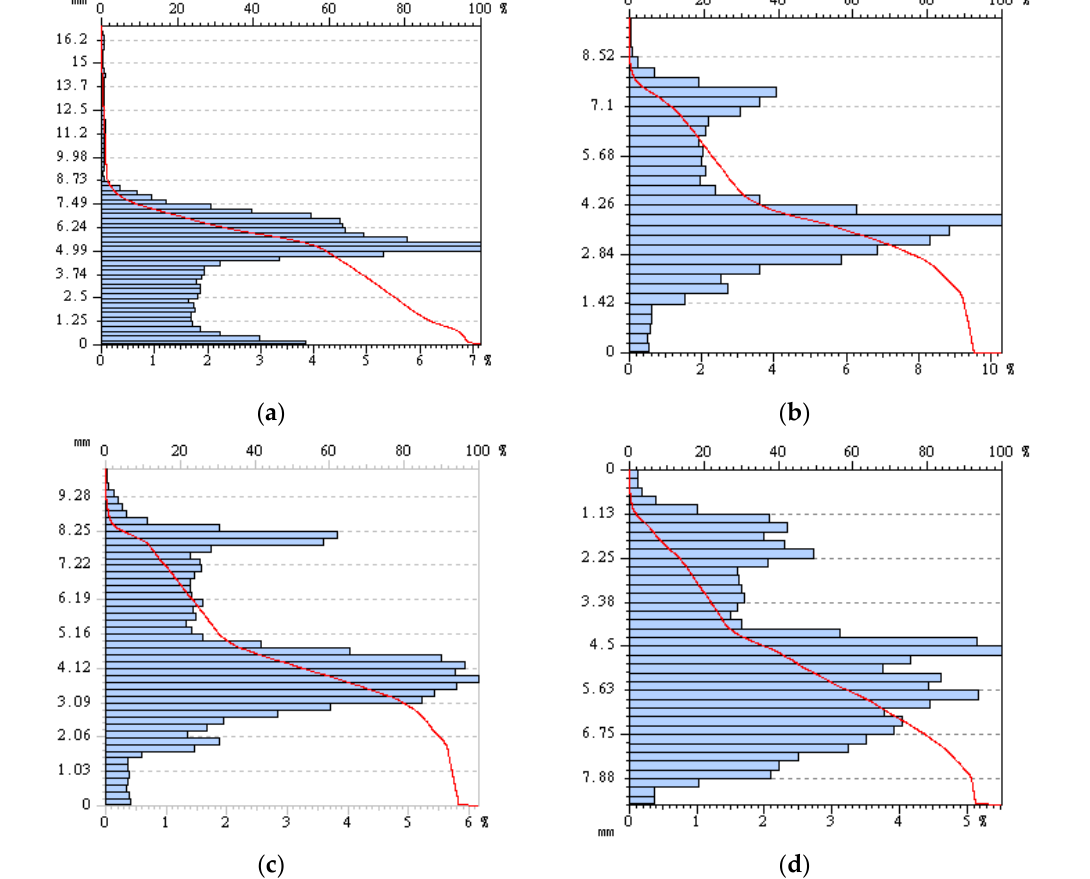
Figure 17. Abbott – Firestone curve of CD-3 in cyclic shearing. ( a ) Before test; ( b ) First shearing; ( c ) Second shearing; ( d ) Third shearing.